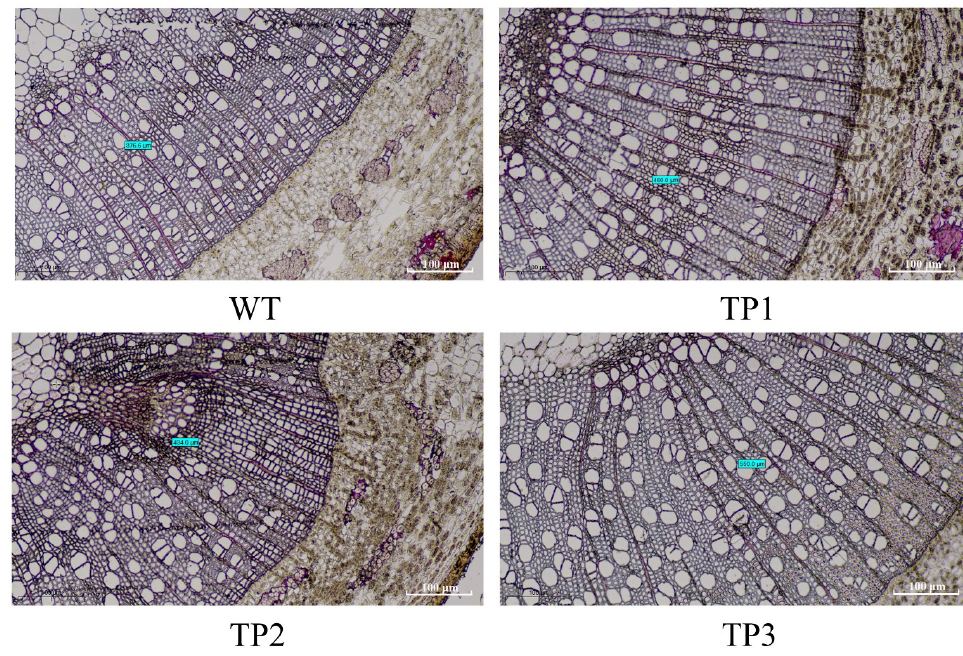
Figure 7. Cross-sections of stems showing increased xylem area in 90 d old wild-type and transgenic plants (lines 1, 2, and 3). Blue is marked as the thickness of xylem per unit area. WT. The thickness of xylem is 376.6 µm. TP1. The thickness of xylem is 450.0 µm. TP1. The thickness of xylem is 434.0 µm. TP1. The thickness of xylem is 550.0 µm.